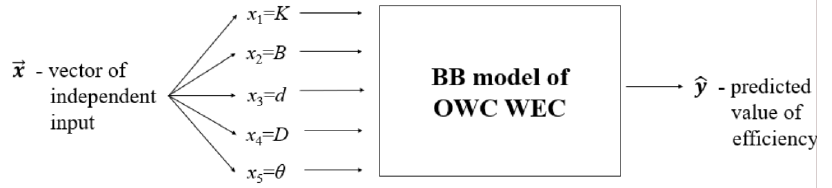
Figure 2. The input-output diagram for a black box (BB) model for hydrodynamic efficiency predictions. (cid:68) → (cid:69) x i , y i Each model can be created using a training set { , for i = 1, 2, . . . , n } consisting of n records from the dataset, where n is selected suitable for the particular model. If the (cid:95) → (cid:95) y x i , then the quantities e i = y i − y model predicts for the input of are called residuals. i i During the training of the model, three measures of the residual magnitudes are used traditionally: the root mean square error ( RMSE ), the mean absolute error ( MAE ) and